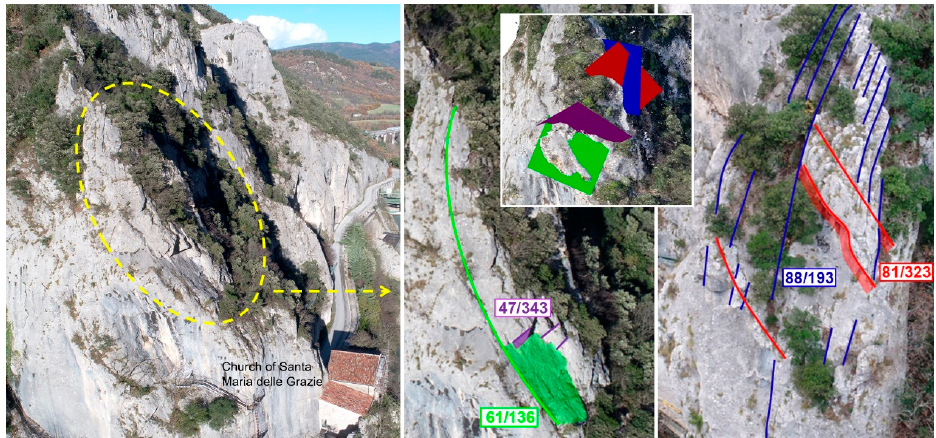
Figure 4. Final stereonet plot of discontinuity poles measured from remote sensing and traditional surveys: joint set sub-division after density analysis is highlighted. Table 2. Mean orientation values of discontinuity sets measured on the study area.